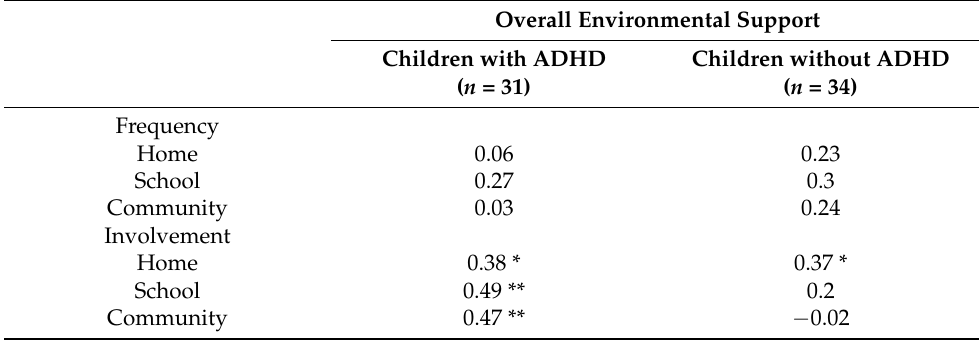
Table 3. Pearson’s correlations between environmental support and participation patterns (frequency and involvement) among children with and without attention deficit hyperactivity disorder (ADHD).